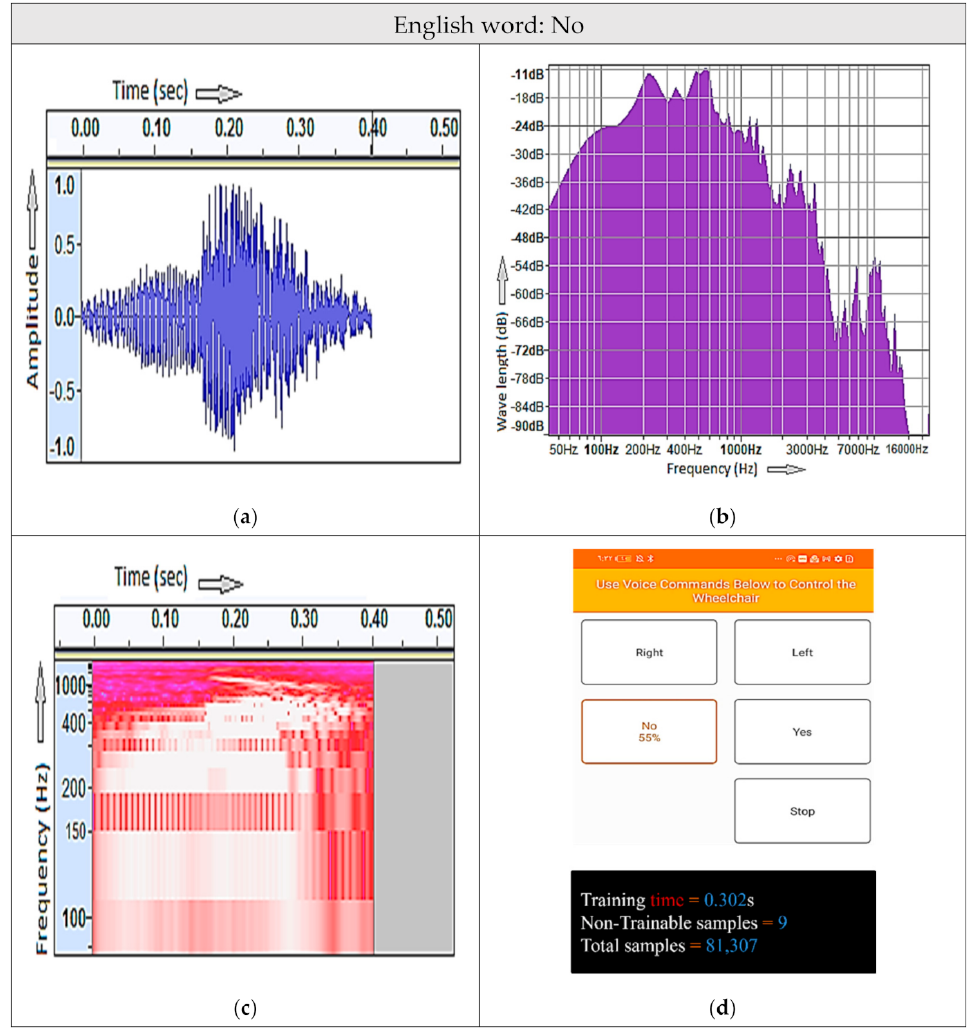
Figure 6. Recognition of the “No” voice command. ( a ) Audio shape; training time = 0.302 s; ( b ) long-